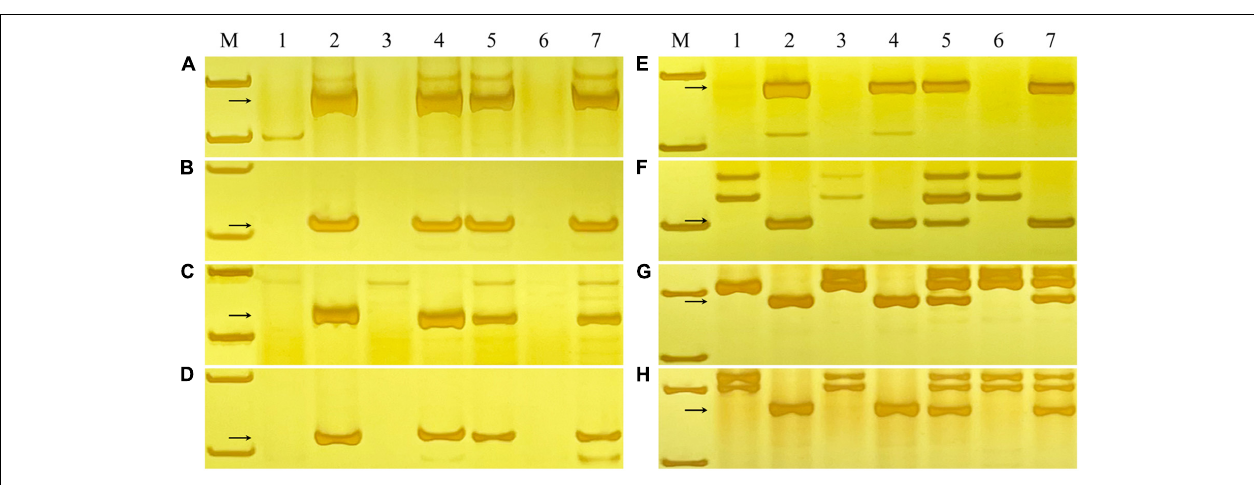
FIGURE 4 | PCR amplification patterns of 6RL-specific markers XM84 , XM86 , XM103 , XM104 , XM108 , XMM20 , XM127 , and XMM47 (A–H) . Lanes M, pUC19 Msp I. 1, Chinese Spring; 2, Weining rye; 3, Holdfast; 4, King II rye; 5, DA 6R of Holdfast × King II; 6, DtA 6RS of Holdfast × King II; 7, DtA 6RL of Holdfast × King II. The arrows indicate the diagnosed amplified